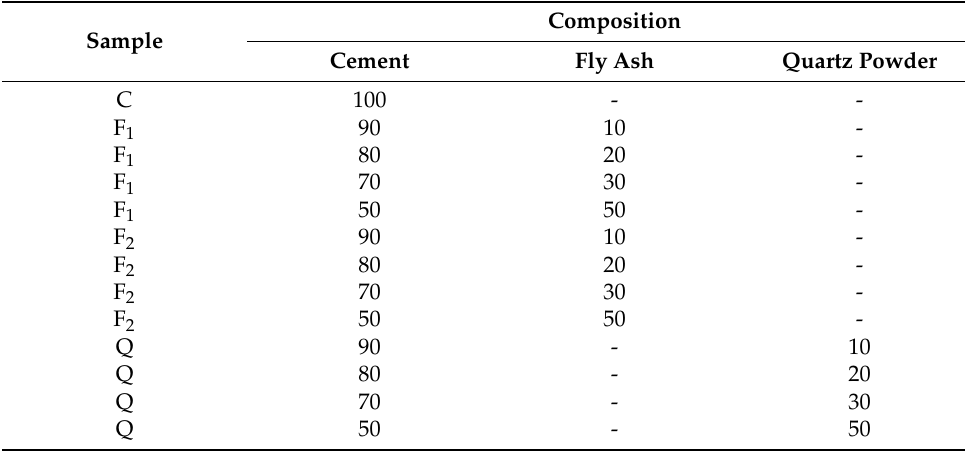
Table 2. Composition of binders